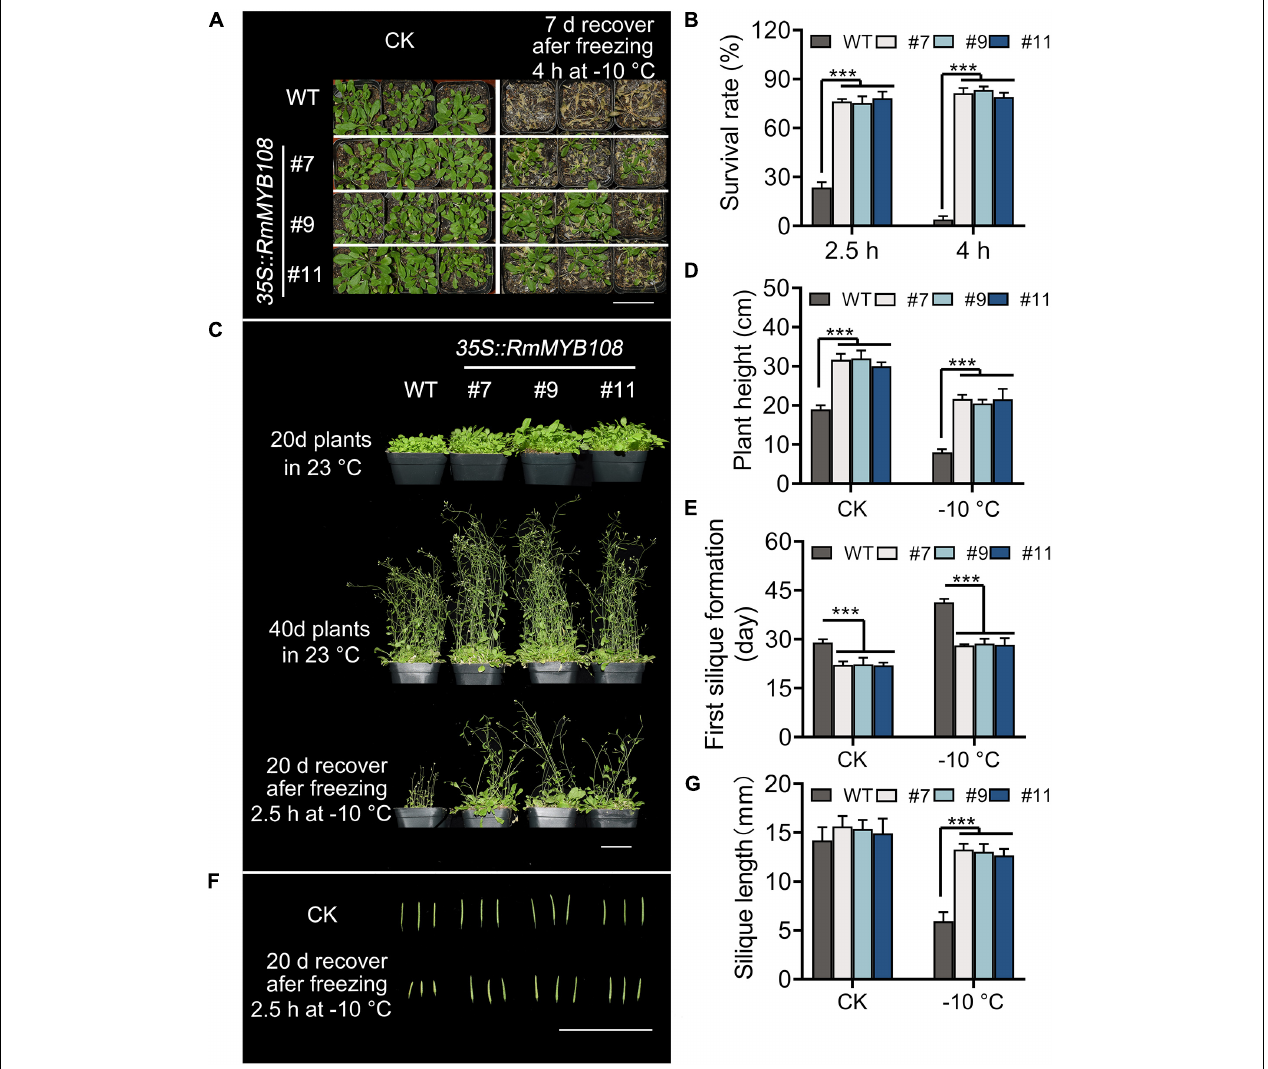
FIGURE 5 | Phenotype of transgenic RmMYB108 plants after shortly freezing at –10 ◦ C at vegetative and reproductive growth stages of plants. (A) Phenotype of 20-days-old WT and OE lines that were treated at –10 ◦ C for 4 h and then recovered for 7 days. (B) Survival rate of recovered plants after being frozen at –10 ◦ C. The 20-day WT and OE lines were pictured after freezing 2.5 h at –10 ◦ C and recovering after 20 days (C) , the plant height (D) , first silique formation time (E) , and silique length (F,G) were measured to show that the overexpression of RmMYB108 enhanced cold tolerance at maturity. Data represent mean value + SD ( n = 20). * p < 0.05; ** p < 0.01; *** p < 0.001 in